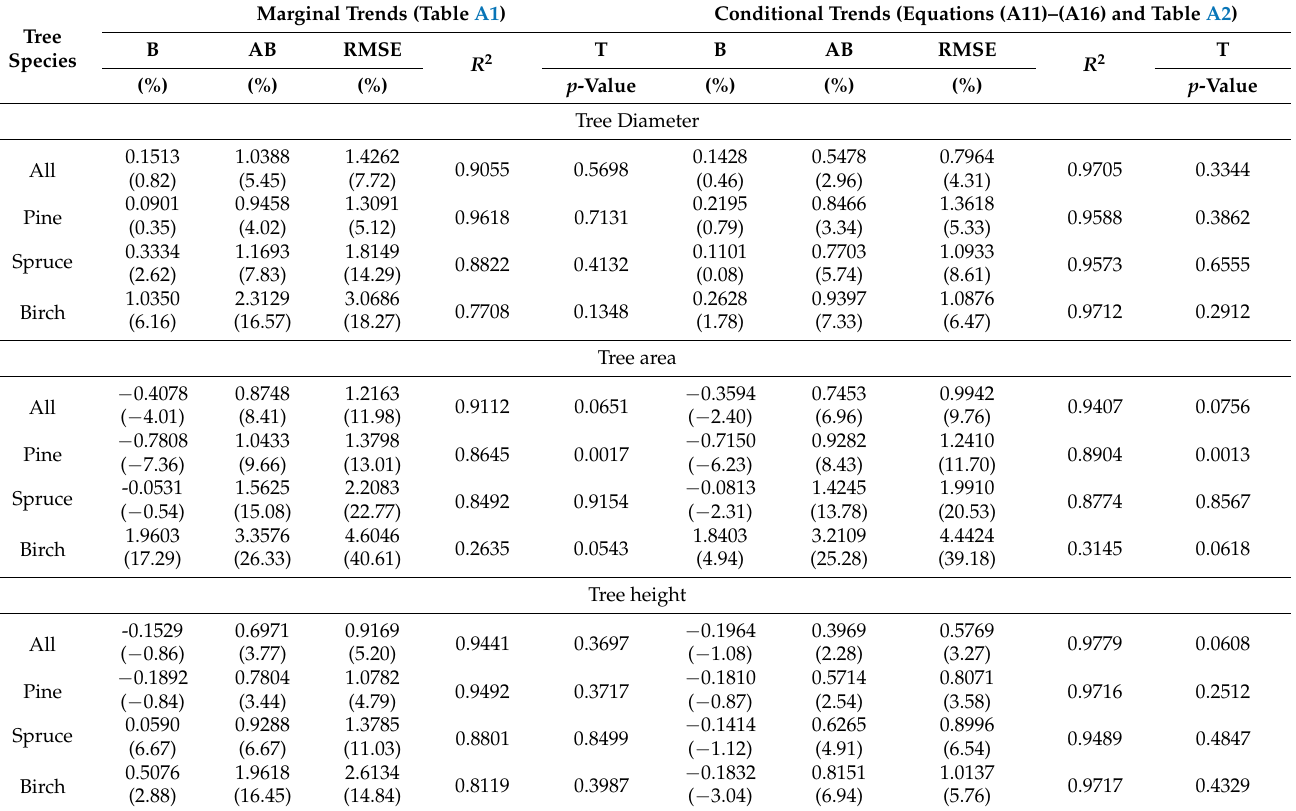
Table 4. Statistical measures and p -values of the Student’s t -test for the predictions of the whole-stand scenario models.